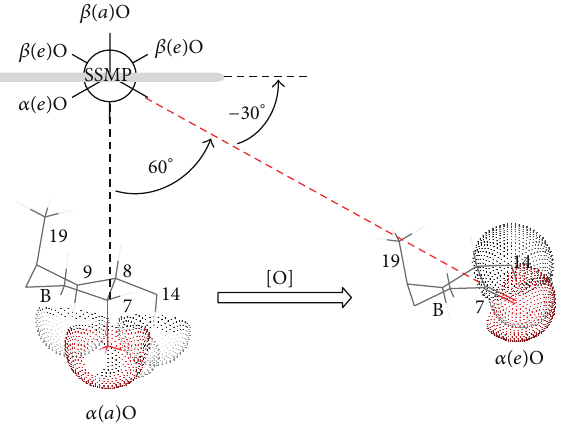
Figure 4: Change in oxygen-core orientation during oxidation.